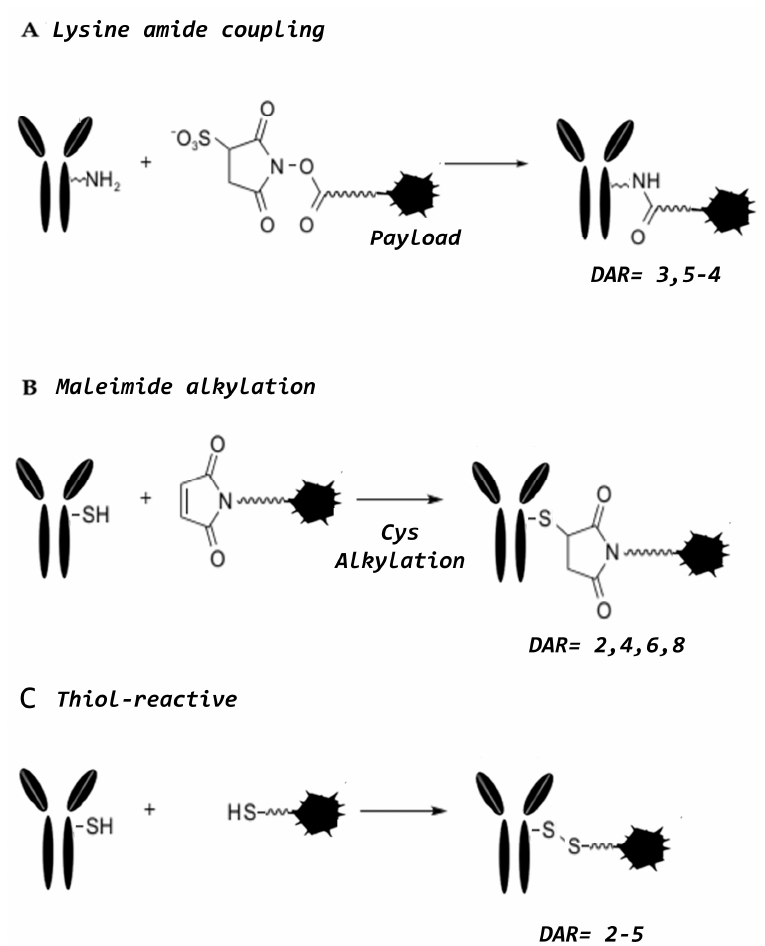
Figure 11. Main reactions used in the cross-linking procedures. ( A ) Lysine amide coupling, ( B ) Maleimide Alkylation, and ( C ) thiol-reactive conjugation.